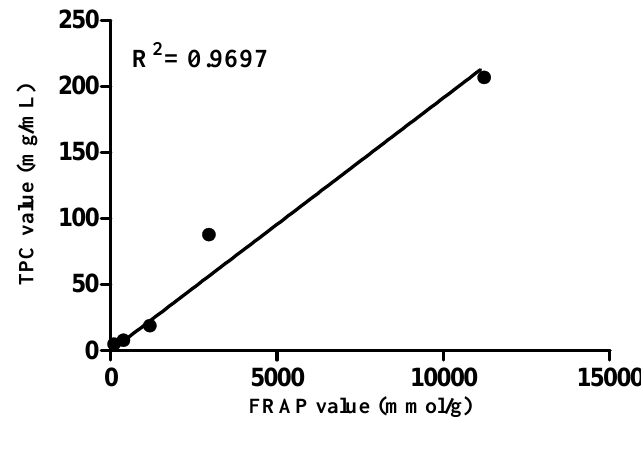
Figure 2. Correlation between total phenolic content and FRAP reducing